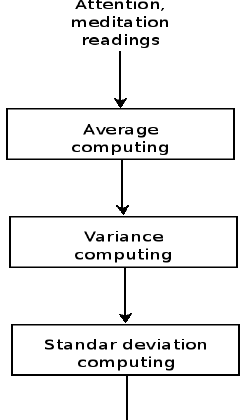
Figure 9. Application signal processing module, adaptive low pass filter, variance and standard deviation computations.